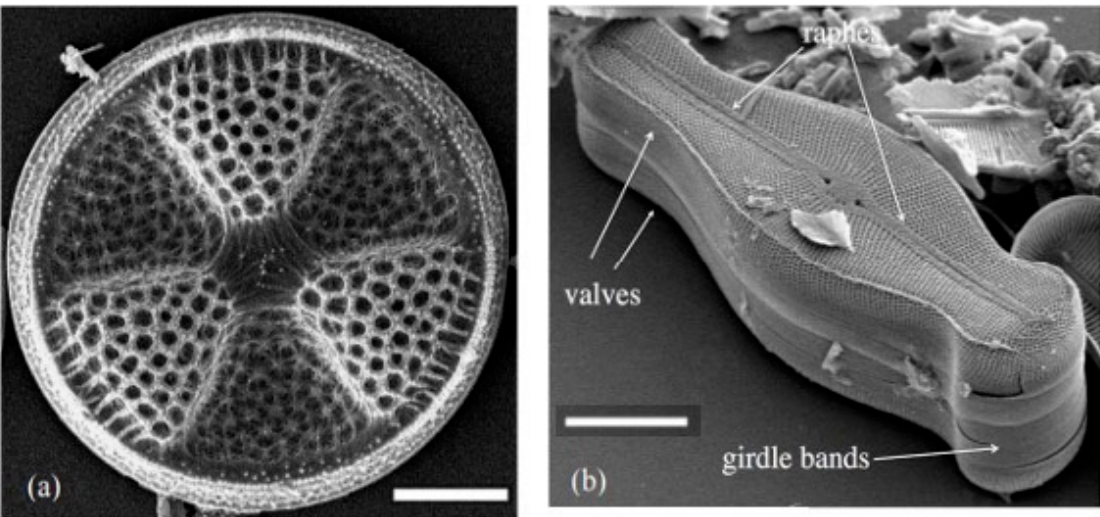
Figure 1. Scanning electron micrograph (SEM) of marine centric Actinoptychus senarius ( a ) and pennate Didymosphenia geminate ( b ) diatom frustules (skeletons). The image shows the typical structure of the frustules. The centric diatom (scale bar 10 µ m) shows a radial symmetry with circular valves, whereas the pennate diatom (scale bar 25 µ m) exhibits bilaterally symmetry. The pore pattern array ( areola ), the girdle bands between the valves, and the raphes are visible. Reproduced from Reference [8] with permission from The Royal Society of Chemistry.